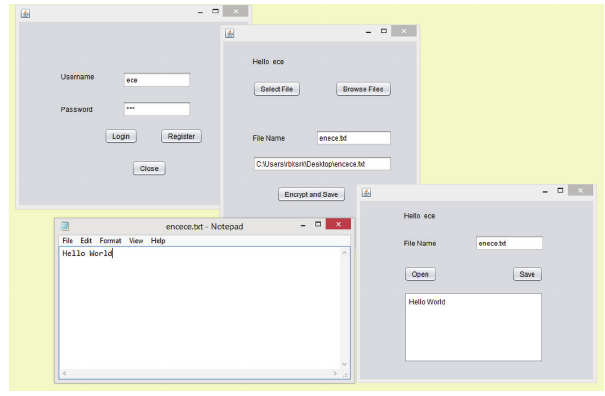
Figure 10: Decryption and saving the